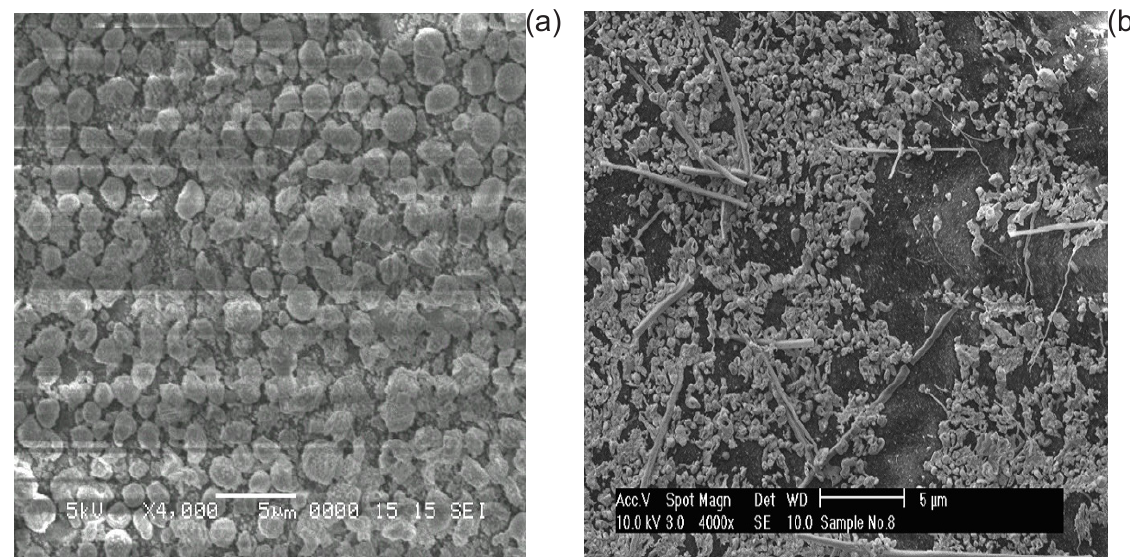
SO solution at 80ºC for 10 min. Concentration of H 2 4